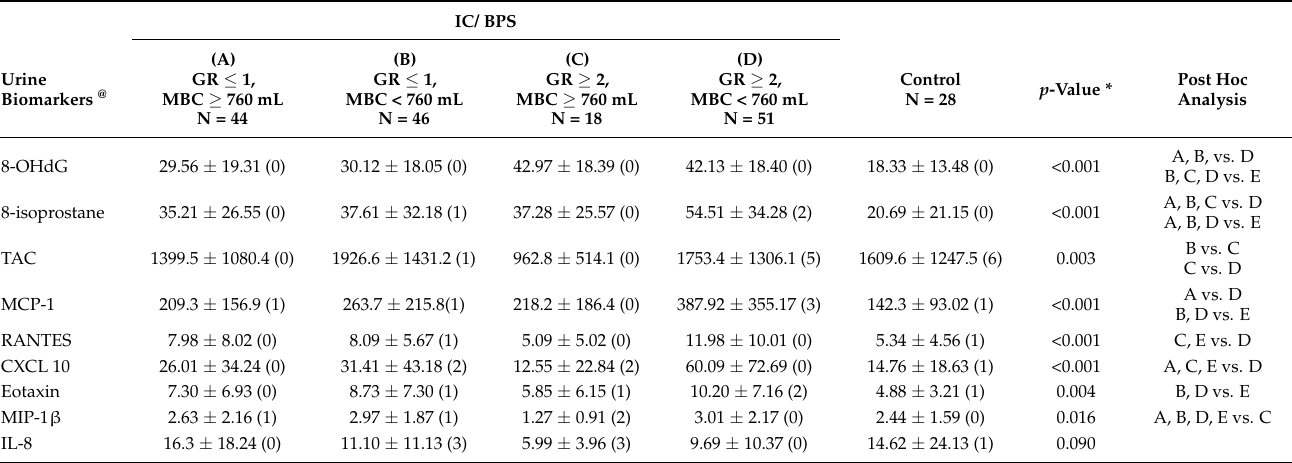
Table 3. Levels of urine biomarkers among different subgroups of patients with IC/BPS and the control patients. IC/ BPS